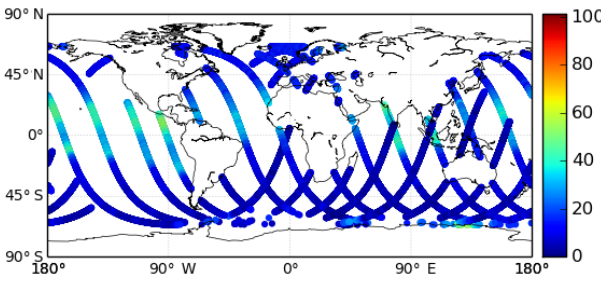
Figure 7. Ground tracks of the Jason-2 altimetry mission for 16 Au- gust 2016 (DOY 229). The colors show the magnitude of VTEC as acquired from the satellite measurement system.